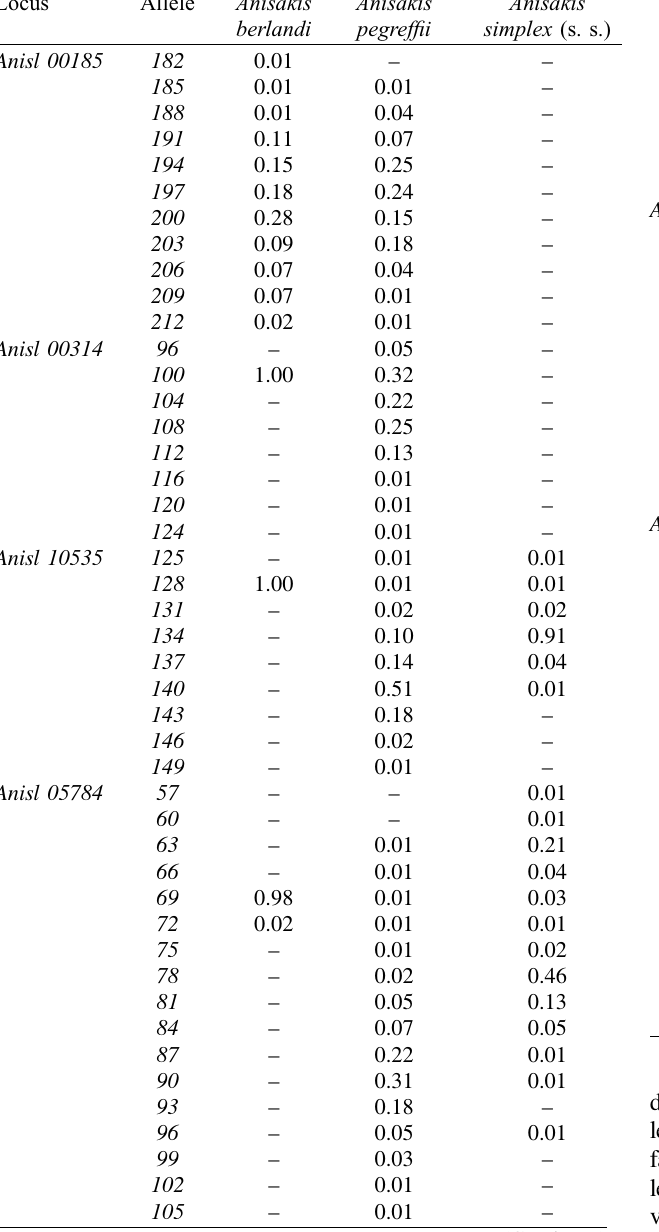
Table 3. Allele frequencies observed at seven microsatellite loci tested in A berlandi, in comparison with those we previously calculated in A. pegref fi i and A. simplex (s. s) at the same SSR loci [9]. With regard to the polymorphic sex-linked locus Anisl 7, the most reliable estimate of allele frequencies was calculated according to the sex-linked genetic model estimate, assuming: (i) hemizygosity of males at this locus; (ii) adult female counterparts as biallelic at the sex-linked loci. The frequencies of Anisl 00185 and Anisl 00314 are not shown in A. simplex (s. s.), because these loci were affected by null alleles, as we have previously found [9].